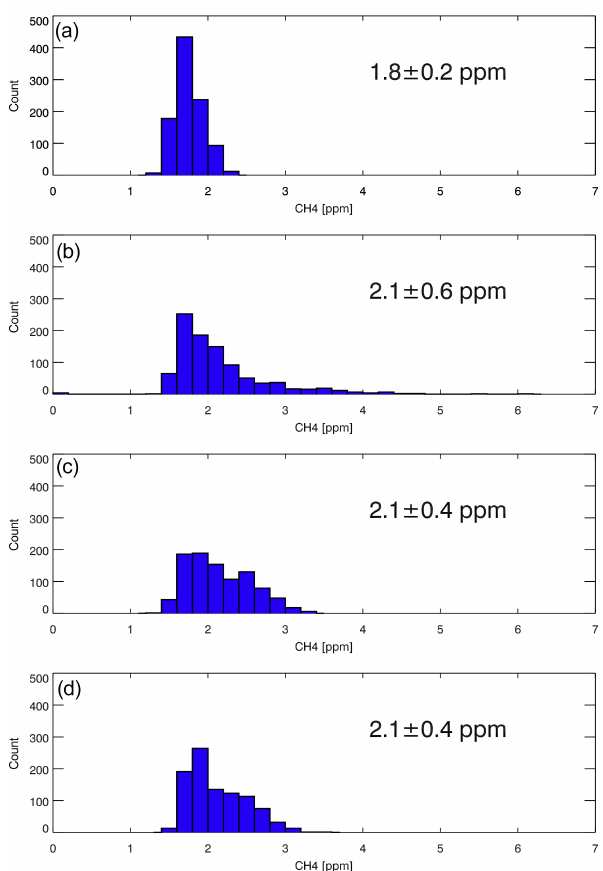
Figure 5. The distributions the CH 4 concentrations in the area of four boxes defined in Fig. 4. (a) Background area; (b) the point source region; (c) and (d) are both downwind